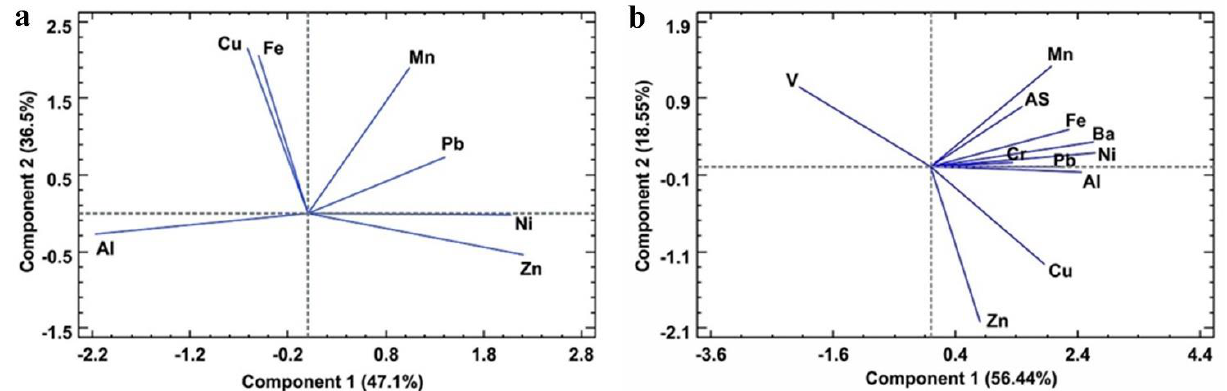
Figure 5. PCA analysis of the studied heavy metals in water ( a ) and sediments ( b